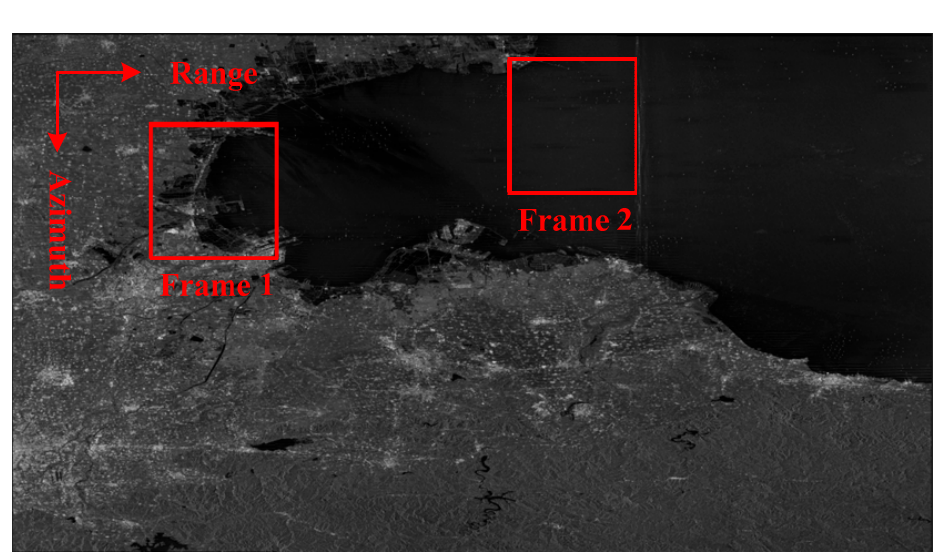
Figure 8. Non-uniform image obtained by GF-3: Scene ID:4295848; Imaging Mode: NSC; Polar Mode: HH; Date: 2017-11-05; Area: Bohai bay, China.